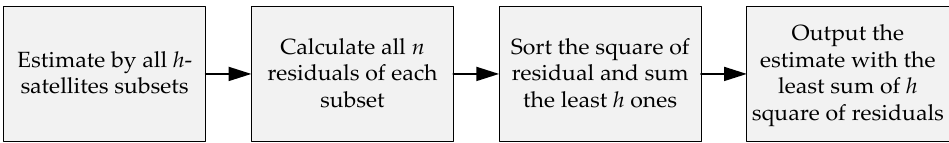
Figure 3. Flow chart of the least trimmed squares (LTS) estimator.